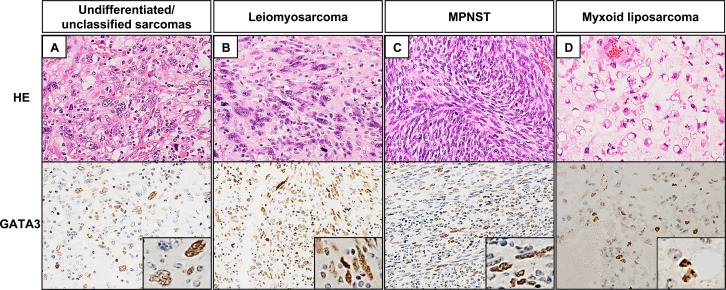
Immunohistochemical detection of GATA3 expression in soft tissue sarcomas (Original magnification, x400; insert, x600).GATA3 was present in the nuclei of STS cells at various proportions. (A) An undifferentiated/unclassified sarcomas case with 30% GATA3 expression. (B) A leiomyosarcoma case with 80% GATA3 expression. (C) A malignant peripheral nerve sheath tumor case with 70% GATA3 expression. (D) A myxoid liposarcoma case with 7% GATA3 expression.